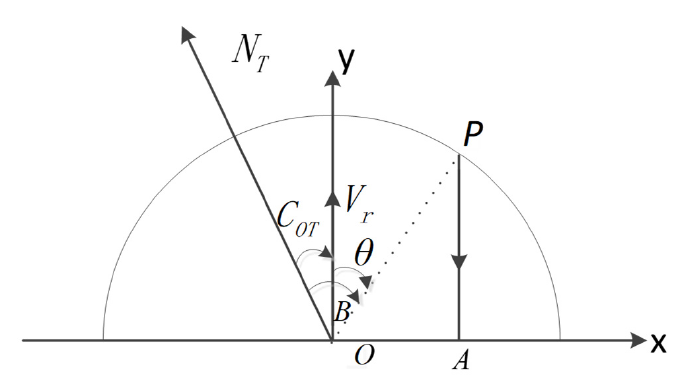
Figure 3. Coordinate system of collision risk